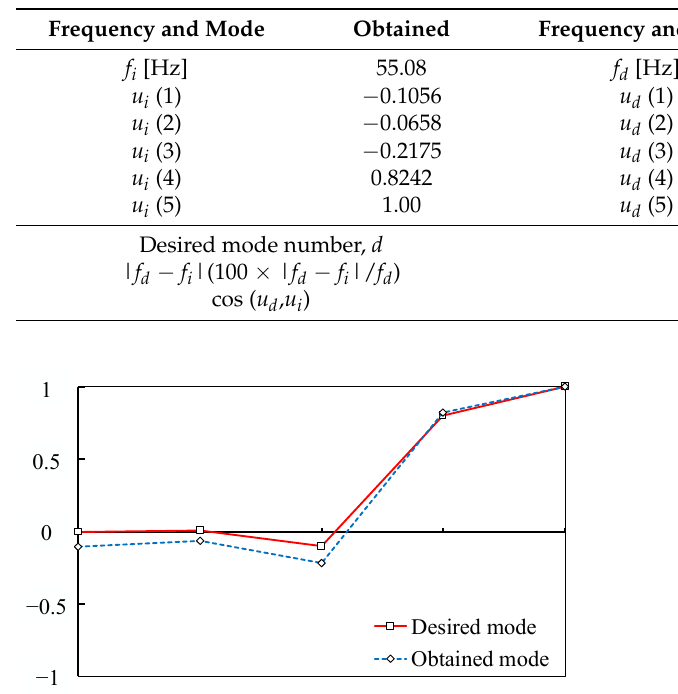
Figure 17. Comparison of desired and attained modes: 55 Hz.